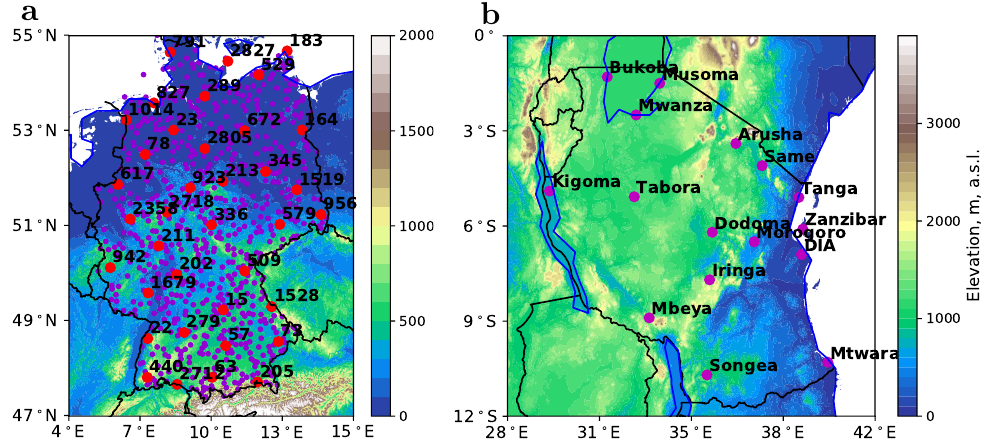
Figure 1. Locations of weather stations and topography of Tanzania and Germany with: ( a ) Climate Data Center (CDC) stations and topography over Germany, where red dots are stations for clustering with their CDC station numbers and purple dots are for classification; and ( b ) Tanzania Meteorological Agency (TMA) stations with their station names and topography over Tanzania. Black lines are political boundaries and blue lines are boundaries of waterbodies, such as lakes and